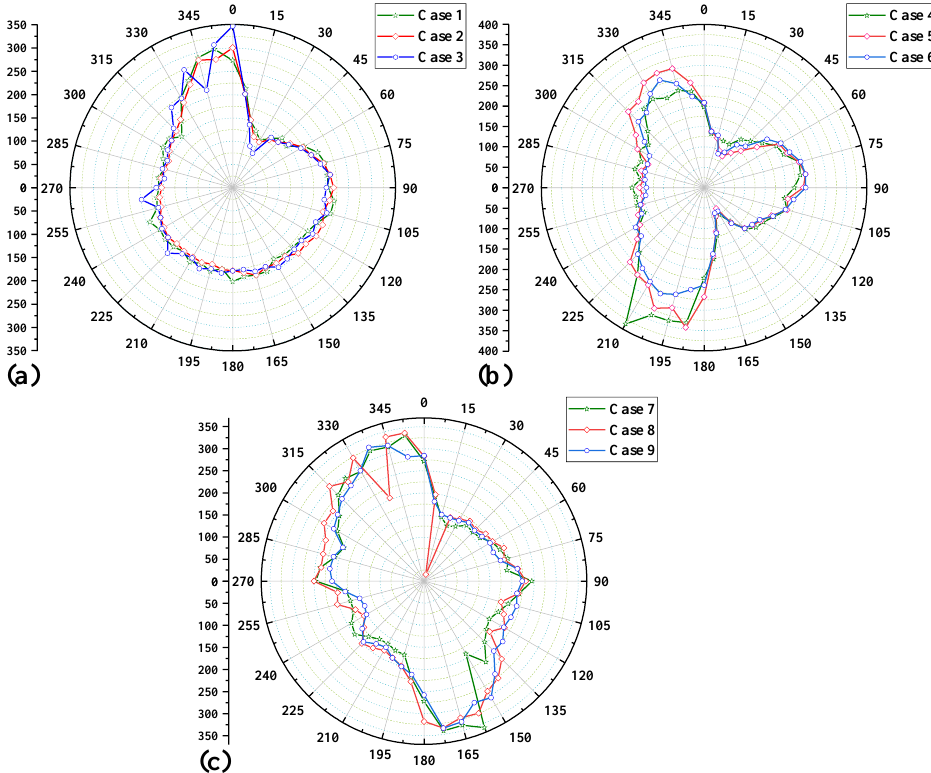
Figure 13. Circumferential residual stress distribution along path-4 for different welding cases. ( a ) Case 1–3 (welding sequence path-1) ( b ) Case 4–6 (welding sequence path-2) ( c ) Case 7–9 (welding sequence path-3).